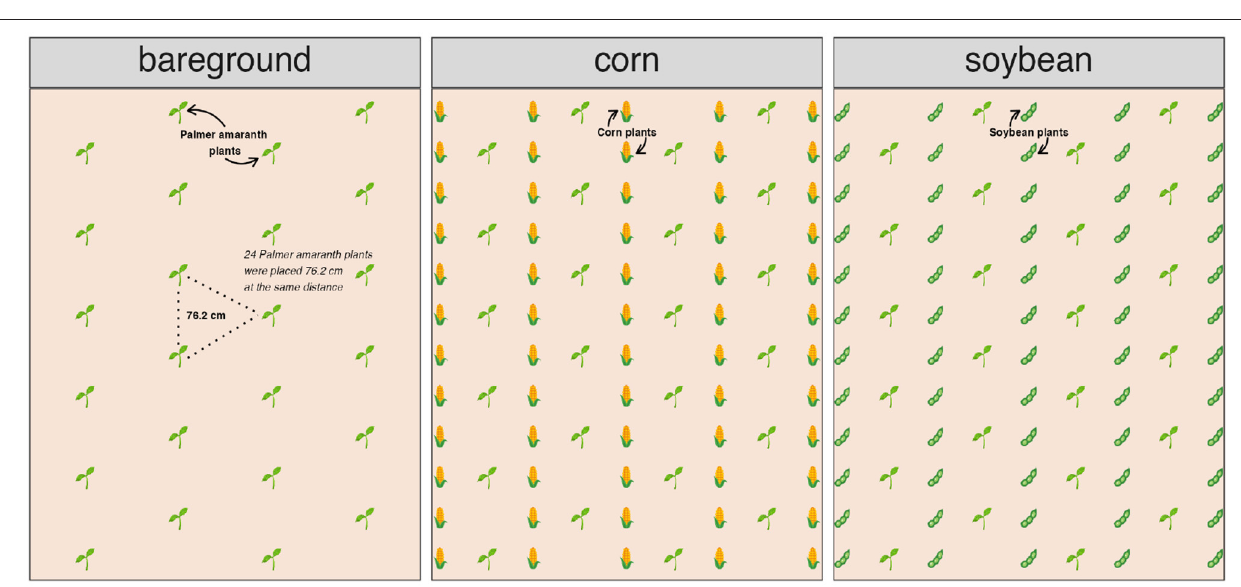
The model accuracy evaluation accuracy in the 20% test dataset was 0.62 with a cutoff value for female and male plants